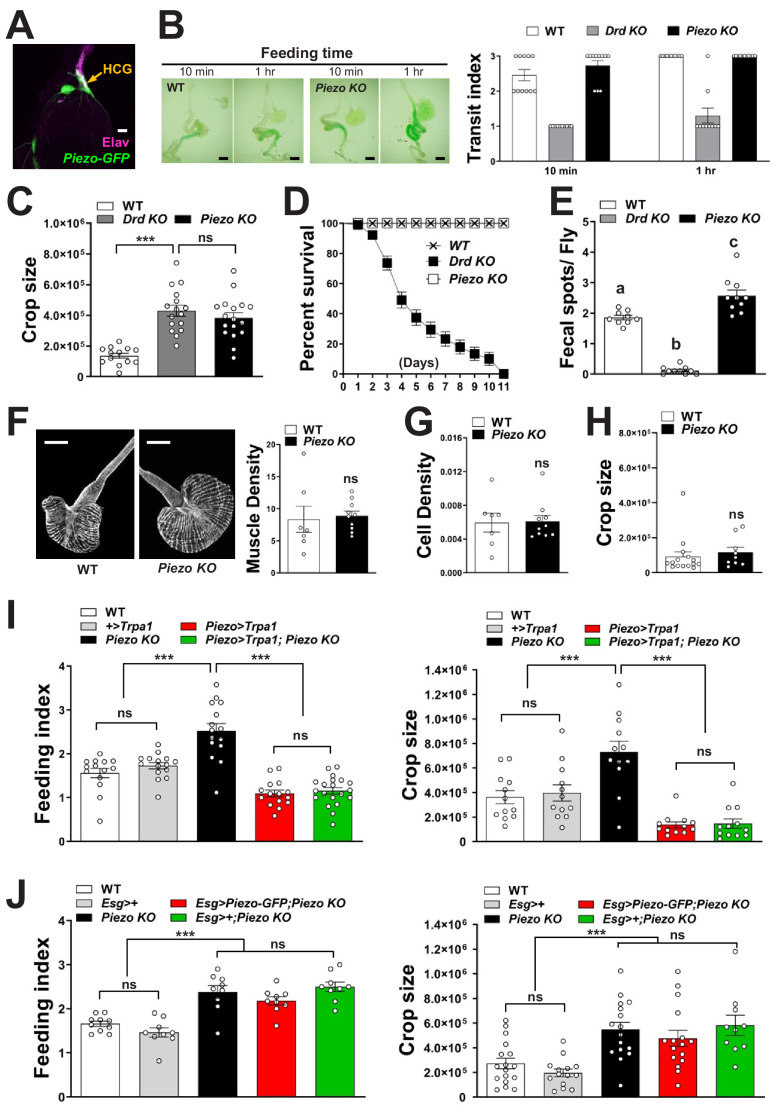
Physiological characterization of Piezo knockout flies.(A) Immunofluorescence for GFP (green) and Elav (magenta) in the hypocerebral ganglion (HCG) of Piezo rescue flies (Piezo knockout; Piezo-Gal4 [59266]; UAS-Piezo-GFP), scale bar 20 μm. (B) Visualizing (left) and quantifying (right) intestinal transit of dye-colored food in wild-type (WT), Drop-dead knockout (Drd KO), and Piezo knockout (Piezo KO) flies. n (left to right): 11, 11, 10, 11, 11, and 10 flies, mean ± SEM, scale bar 200 μm, differences between WT and Piezo KO were not significant by either ANOVA Dunnett’s multiple comparison test or by Fisher's exact test. Measurements of (C) crop size, (D) survival, and (E) fecal spot deposition in WT, Piezo KO, and Drop-dead KO flies. n (left to right) for (C): 13, 16, and 17 flies; for (D): 8, 7, and 7 trials involving 12 flies per trial for WT, Drd KO, and Piezo KO involving 84–96 flies; for (E): 9, 10, and 10 trials involving 10 flies per trial, mean ± SEM, ***p<0.0001; ns: not significant by ANOVA Dunnett’s multiple comparison test; statistical comparison by ANOVA Dunnett’s multiple comparison test of (a)–(c): p=0.0006, of (a, b): p<0.0001. (F) Visualization (left) and quantification (right) of muscle fiber density by a fluorescent Phalloidin conjugate, n: 7 (left) and 10 (right) flies, mean ± SEM, scale bar 100 μm. (G) Quantification of crop cell density based on nuclear staining (TO-PRO-3), n: 7 (left) and 10 (right) flies, mean ± SEM. (H) Measurement of crop size in fasted flies, n: 15 (left) and 9 (right) flies, mean ± SEM. (I) Fasted flies of genotypes indicated were given brief access (30 min) to dye-labeled food at 30°C, and feeding indices and crop sizes were calculated. n (left to right) (feeding index): 14, 15, 15, 15, and 20 trials involving 12 flies per trial. n (crop size): 12 flies, mean ± SEM, ***p<0.0005, ns: not significant by ANOVA Dunnett’s multiple comparison test or unpaired t-test. (J) Fasted flies of genotypes indicated were given brief access (30 min) to dye-labeled food, and feeding indices and crop sizes were calculated. n (left to right) (feeding index): 10, 9, 9, 9, 9, and 9 trials involving 12 flies per trial. n (crop size): 17, 15, 14, 16, 16, and 10 flies, mean ± SEM, ***p<0.0005, ns: not significant by ANOVA Dunnett’s multiple comparison test.
Figure 4—figure supplement 1—source data 1.Numerical data to support the graph in Figure 4—figure supplement 1.